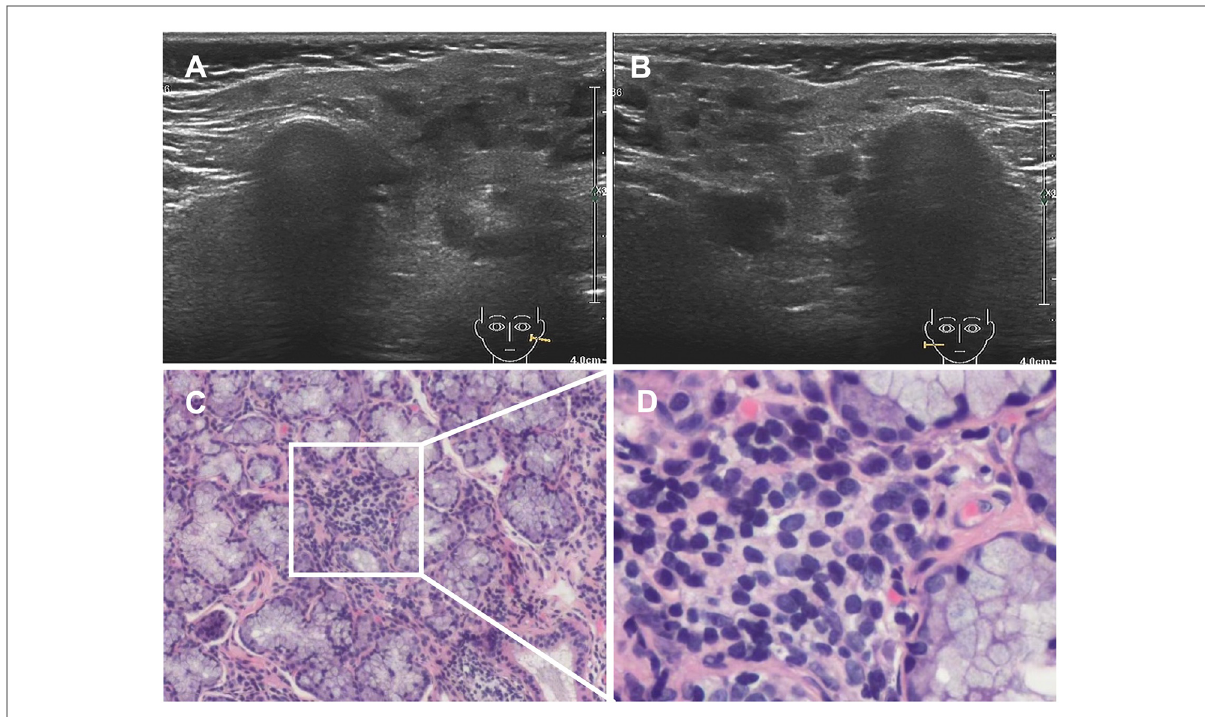
FIGURE 3 Results of ultrasound and LSGB. ( A , B ) Ultrasound scan showing diffuse bilateral parotid lesions. ( C,D ) LSGB revealing multifocal lymphocytic in fi ltration between lobules, dilated interlobular ducts, and occasional destruction of the gland. LSGB, labial salivary gland